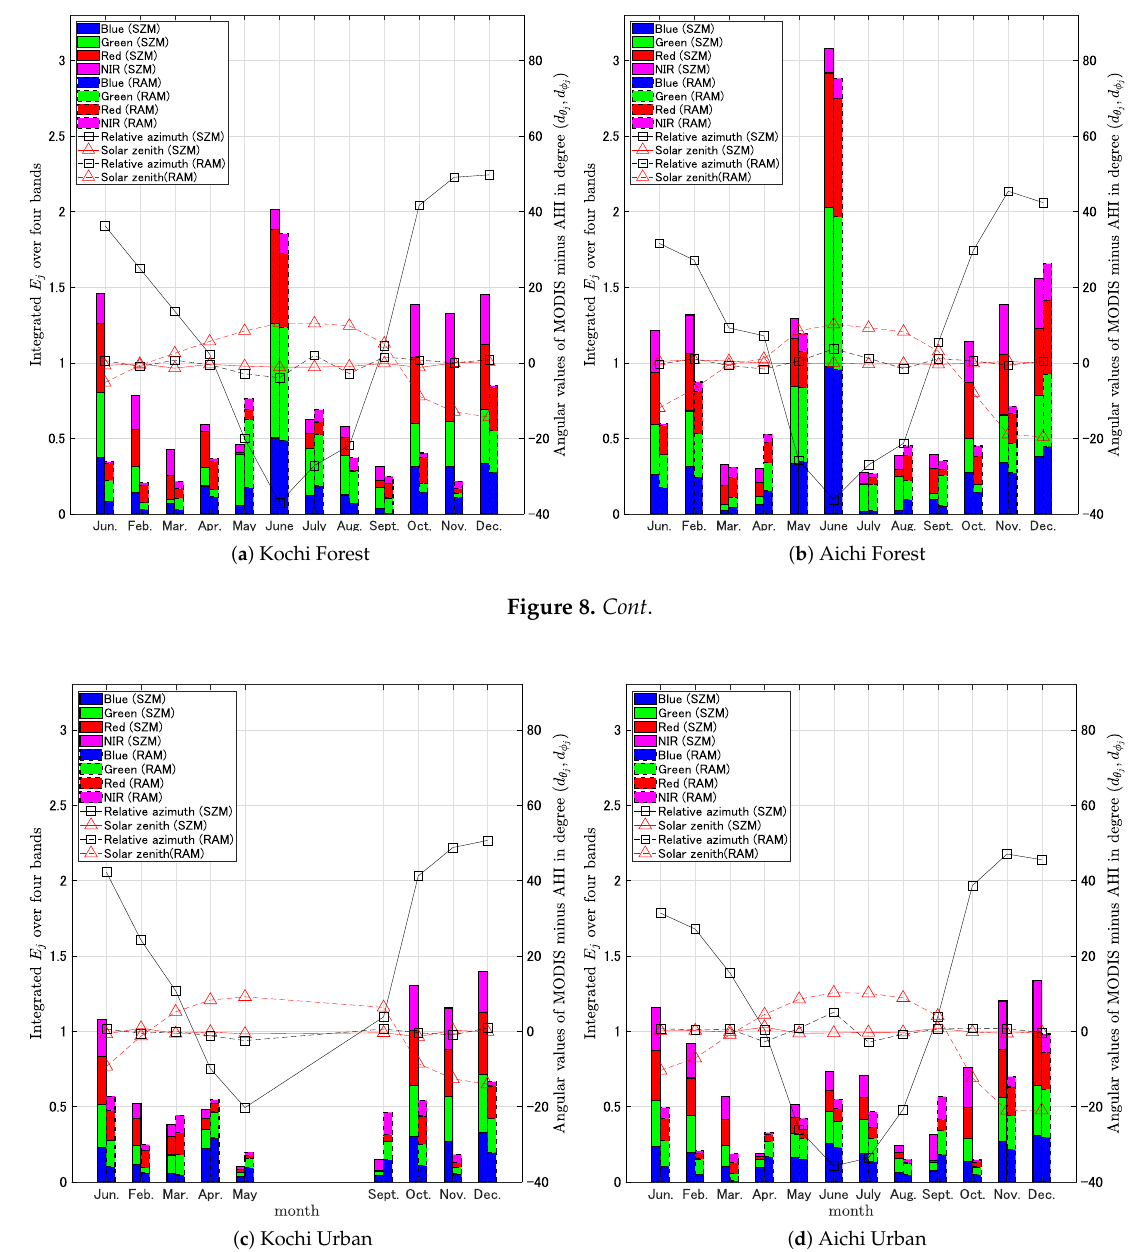
Figure 8. Integrated values of E j = | 1 − r j | over the four bands, obtained using the SZM and RAM methods. Differences in the MODIS and AHI relative azimuth angles and solar zenith angles are plotted on the secondary y-axis: ( a ) Kochi Forest; ( b ) Aichi Forest; ( c ) Kochi Urban; and ( d ) Aichi